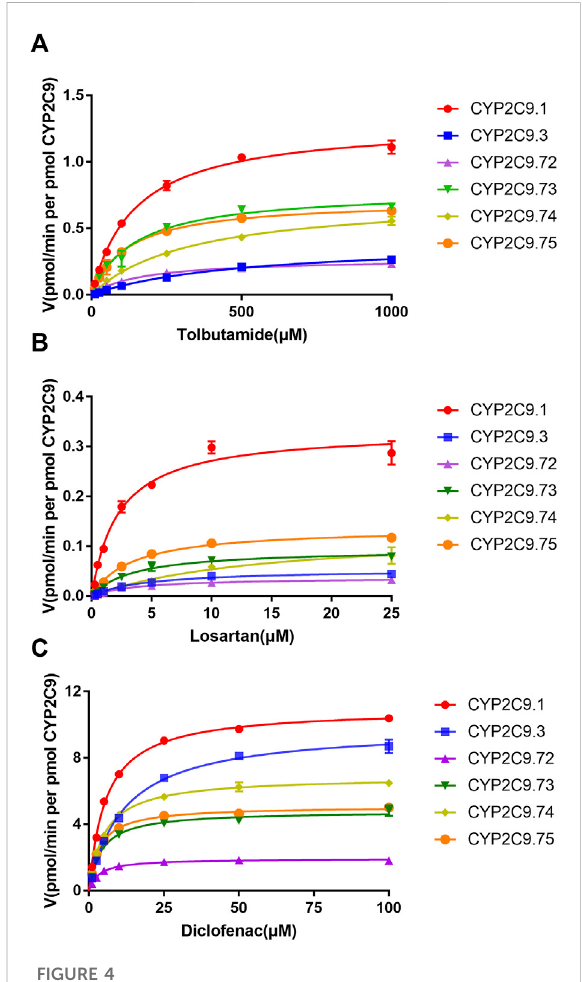
FIGURE 4 Michaelis – Menten curves for the hydroxylation of three CYP2C9 probe substrates tolbutamide (A) , losartan (B) and diclofenac (C) by the recombinant CYP2C9 variants. Each point represents the mean ± standard deviation of at least three independent